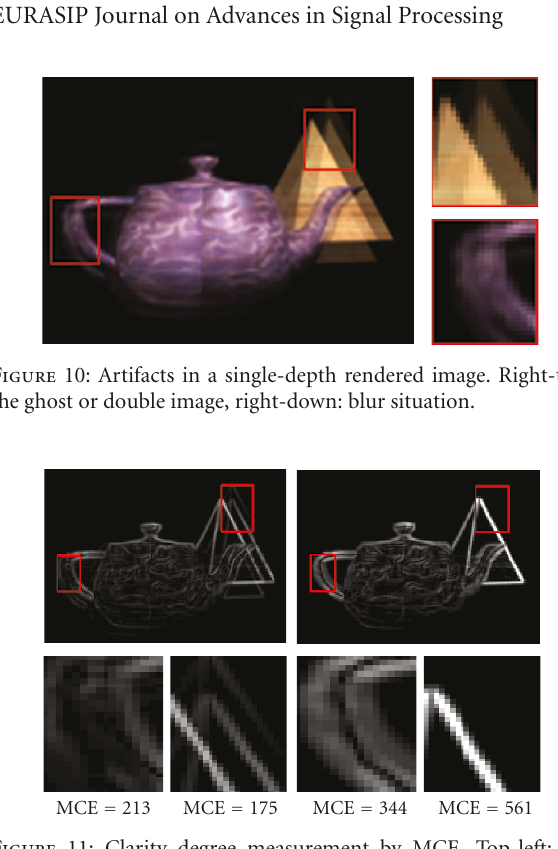
Figure 11: Clarity degree measurement by MCE. Top-left: the derivative of a single-depth rendered image; Top-right: the deriva- tive of an all-clear image. The second row: local regions and their MCE values. The higher MCE reflects better clarity.